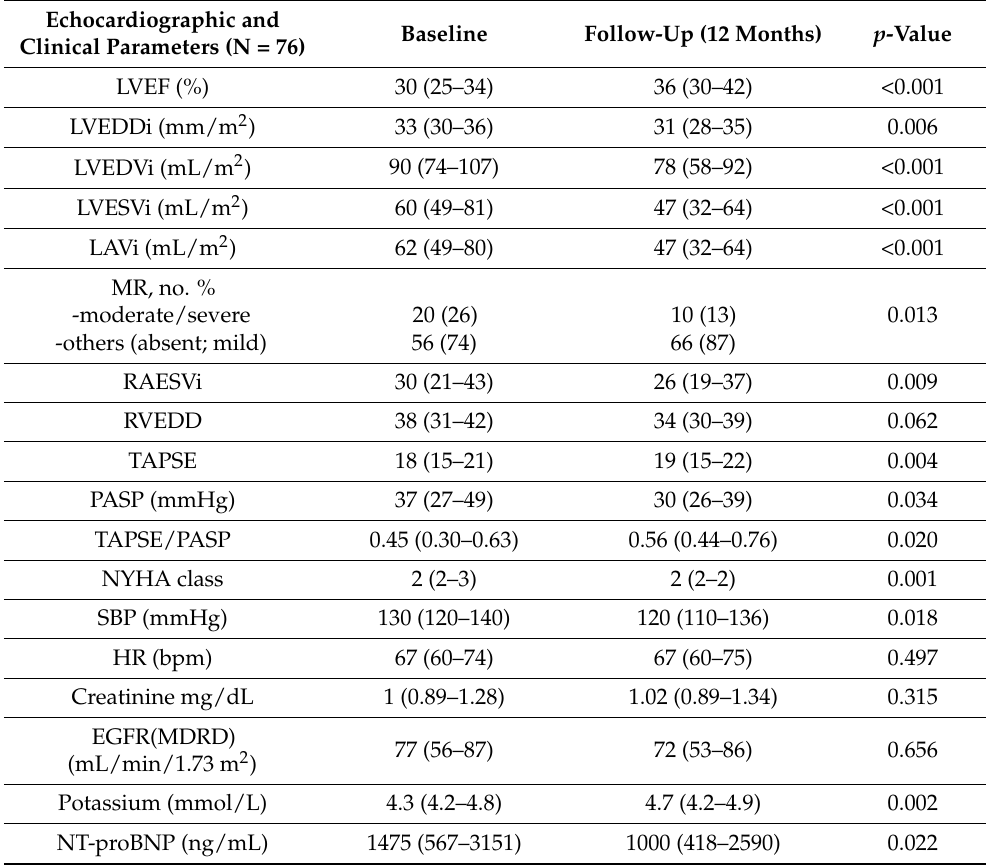
Table 2. Comparison between baseline and follow-up clinical, laboratory, and echocardiographic parameters applying the Wilcoxon Signed Rank for continuous variables (paired samples) or the McNemar for categorical variables (paired